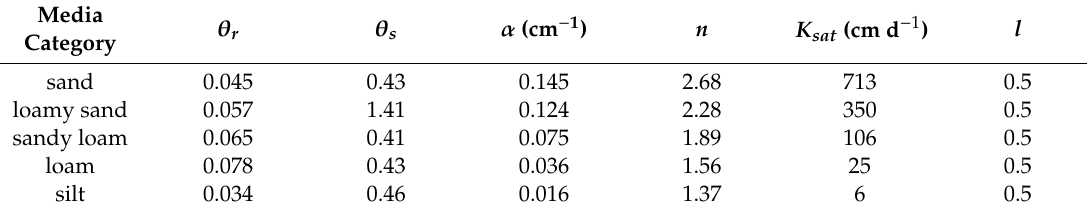
Table 2. Soil hydraulic parameters [37] for soil textures [40] used in example